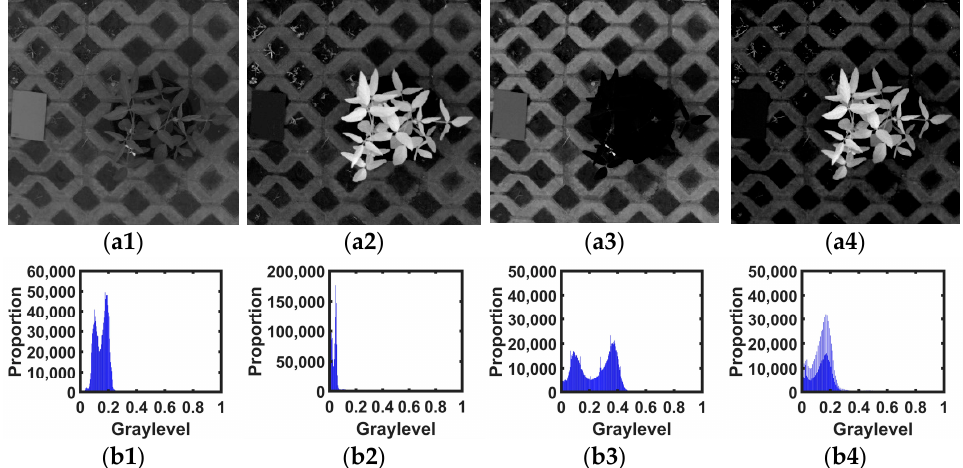
Figure 7. Median filtering effect and corresponding histogram of the soybean multispectral image: ( a1 ) GRE median filter, ( a2 ) NIR median filter, ( a3 ) RED median filter, ( a4 ) REG median filter, ( b1 ) GRE histogram, ( b2 ) NIR histogram, ( b3 ) RED histogram and ( b4 ) REG histogram.